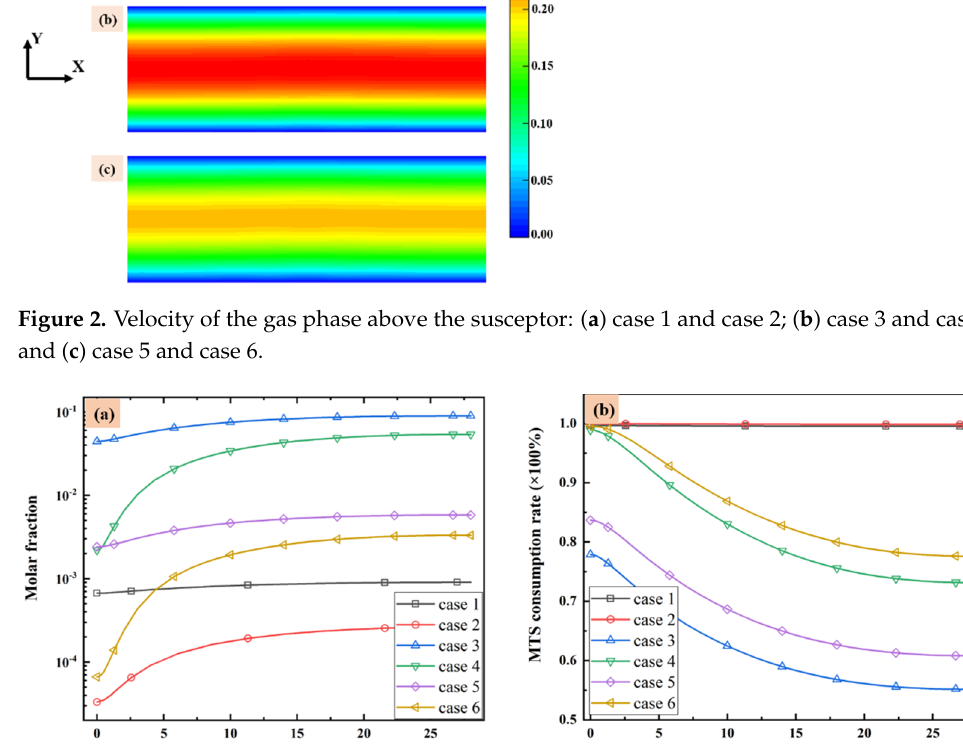
Figure 3. ( a ) MTS molar fraction and ( b ) MTS consumption rate along line B.